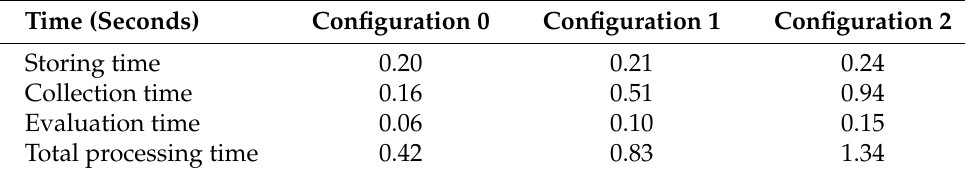
Table 8. Processing time (in seconds) for different window size